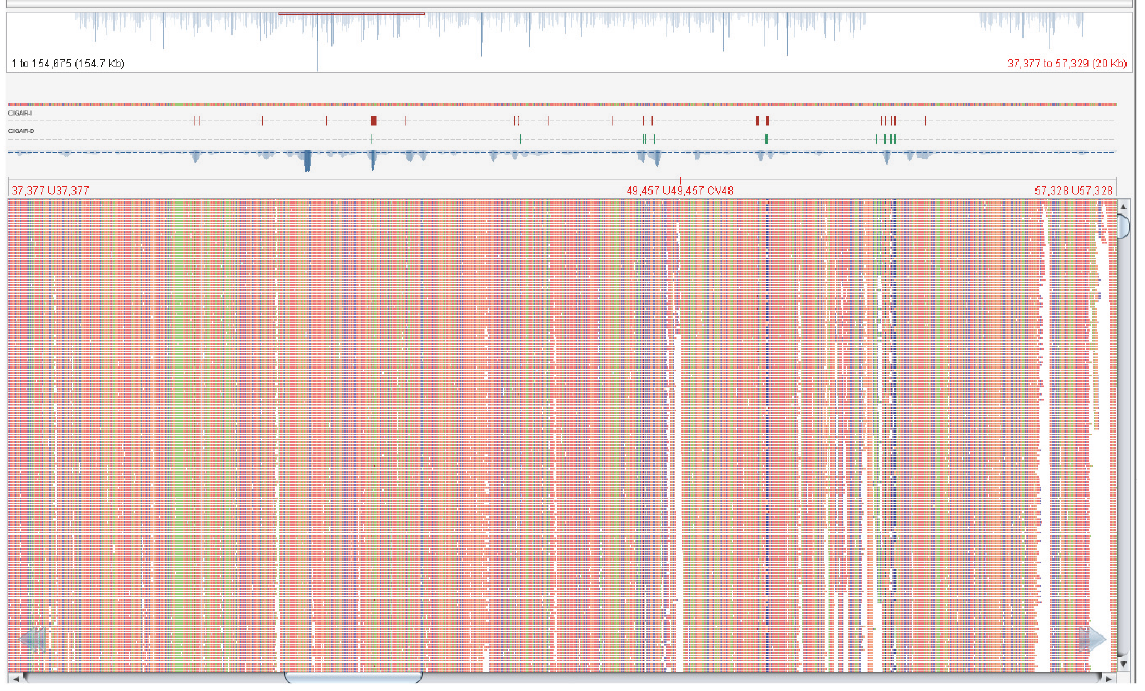
Figure 4: Alignment of patient serum RNA against human herpesvirus 2 reference genome. Reads were aligned using Bowtie2 and displayed using Tablet viewer